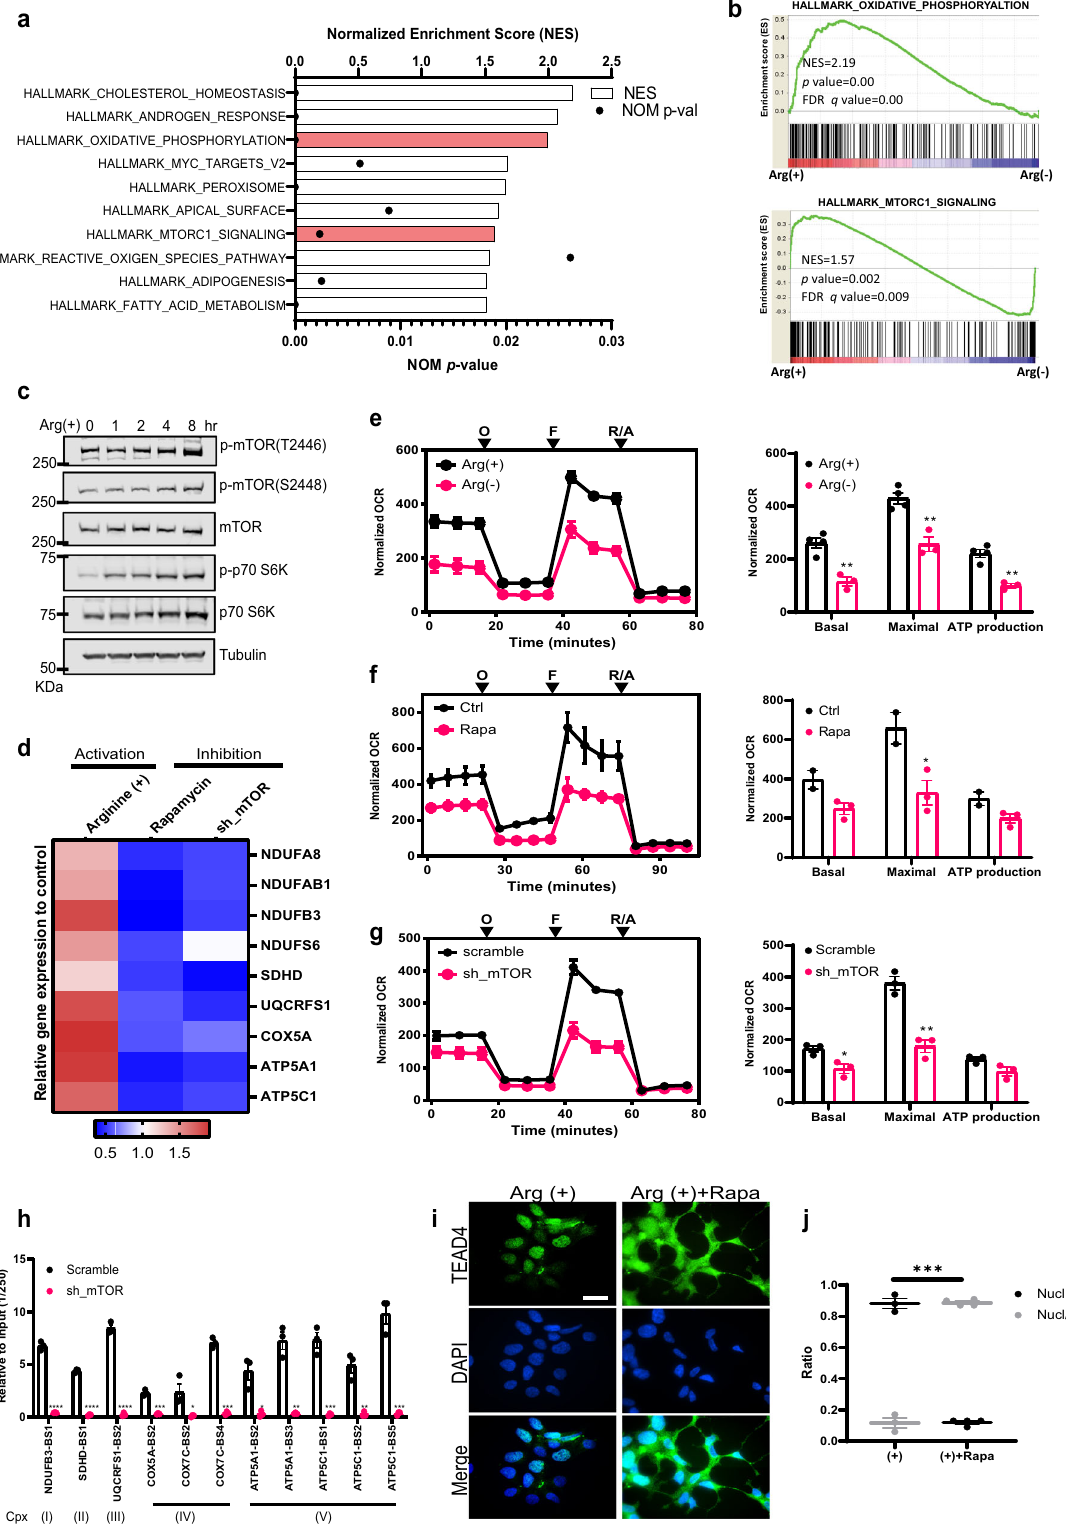
In vitro, silencing of TEAD4 in prostate cancer cells signi fi cantly inhibited cell growth (Fig. 7f for CWR22Rv1 and Supplementary Fig. 1g for PC3) and increased the cell doubling time (Fig. 7g). In vivo, silencing of TEAD4 by shRNA (Fig. 7h, i and Supplemen- tary Fig. 4c) or CRISPR-Cas9 KO of both TEAD4 alleles (Fig. 7j, k